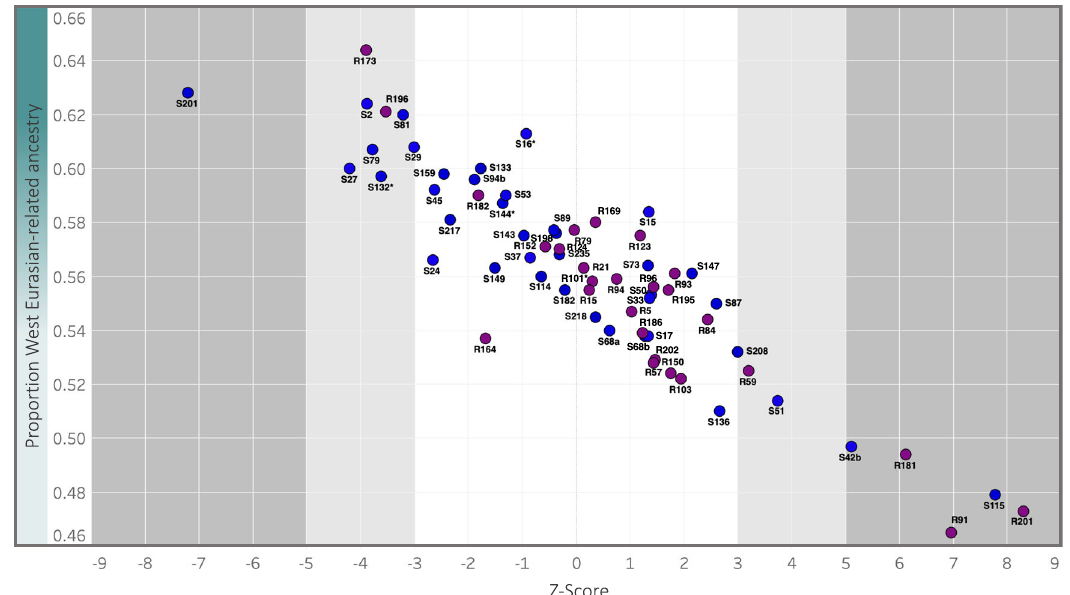
Fig. 3 Identifying genetic outliers at Kulubnarti. We plot the Z-score for the statistic f 4 ( Nilotic_Test, WestEurasia_Test; Individual, Kulubnarti_Without_Individual) for each individual at Kulubnarti (purple and blue circles represent R and S cemetery individuals, respectively) on the x-axis against the point estimate of West Eurasian-related ancestry on the y-axis (data in Supplementary Data 6). At |Z| > 5 (dark gray area), we consider individuals to be genetic outliers; individuals with |Z| > 3 (light gray area) were not considered outliers at the threshold set for this work. Asterisks (*) denote lower-coverage fi rst-degree relatives of other individuals in the